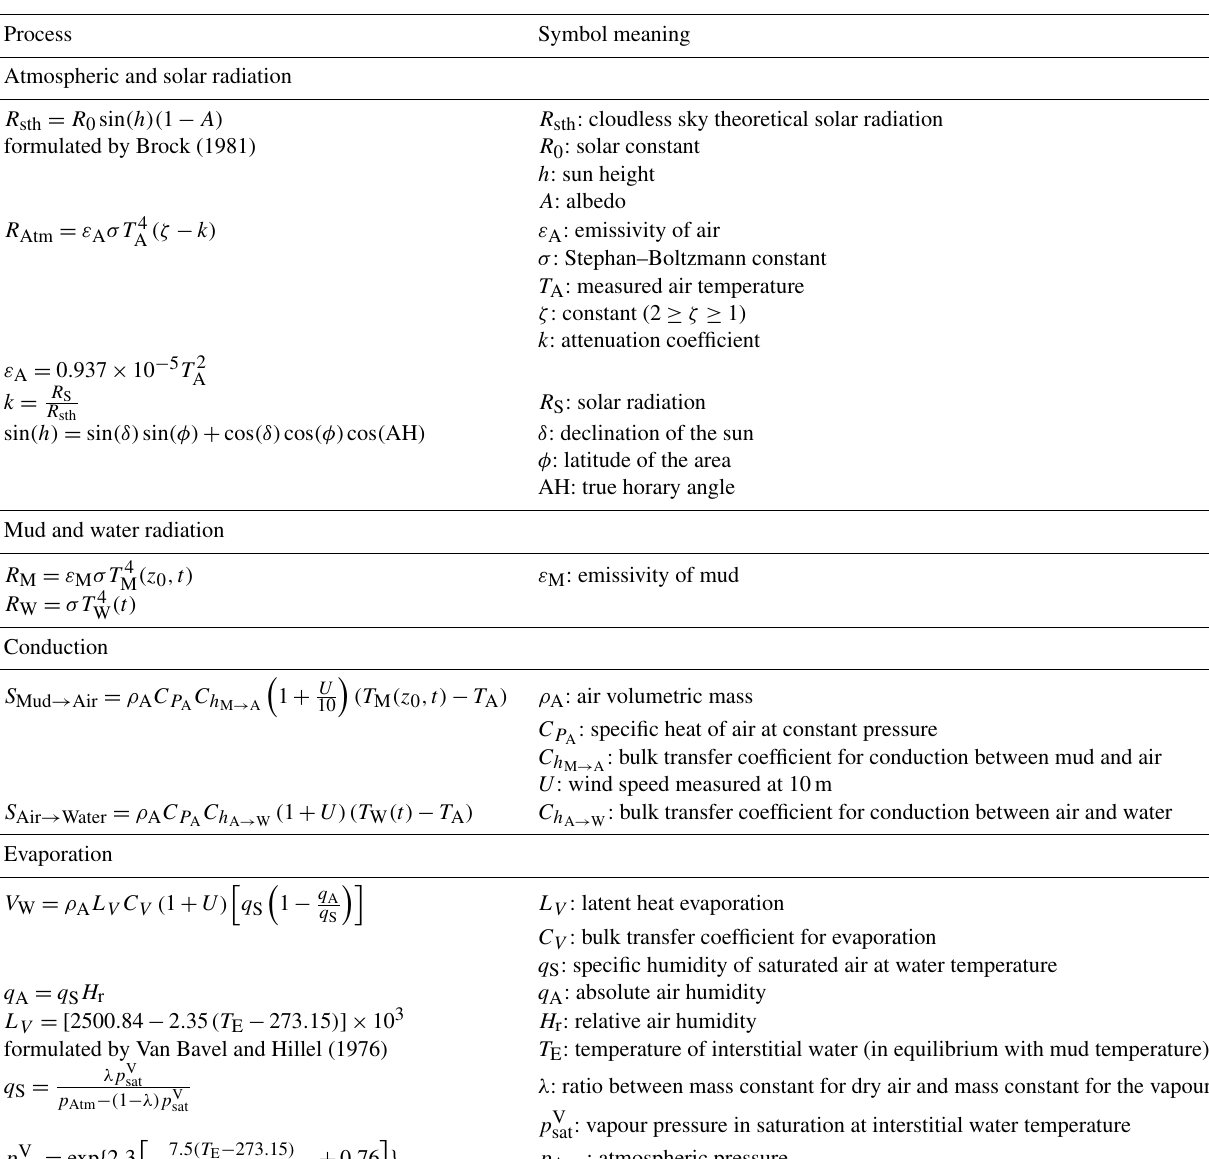
Table A1. Equations of the processes involved in the sediment temperature